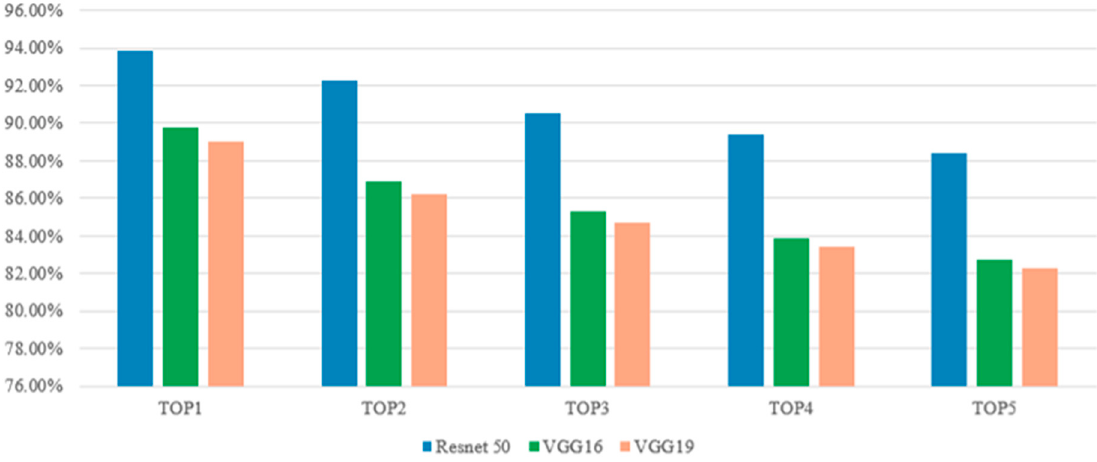
Figure 6. Performance of pre-trained models in hot pepper diseases with top-1~top-5 results.